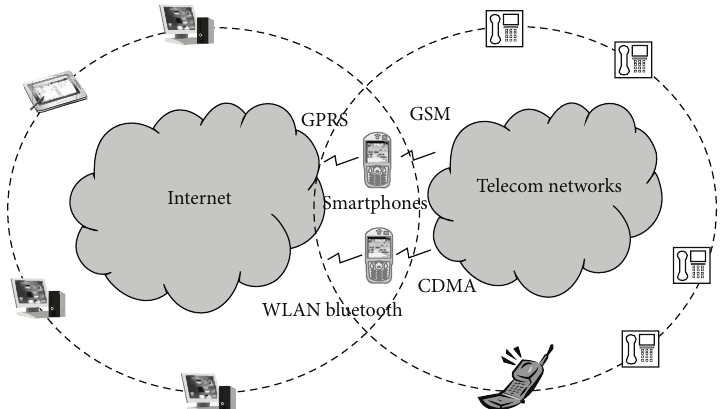
Figure 1: Mobile devices have become a common place for both Internet and telecom networks. They have been combined into a sound framework which allows different media to communicate with each other immediately and